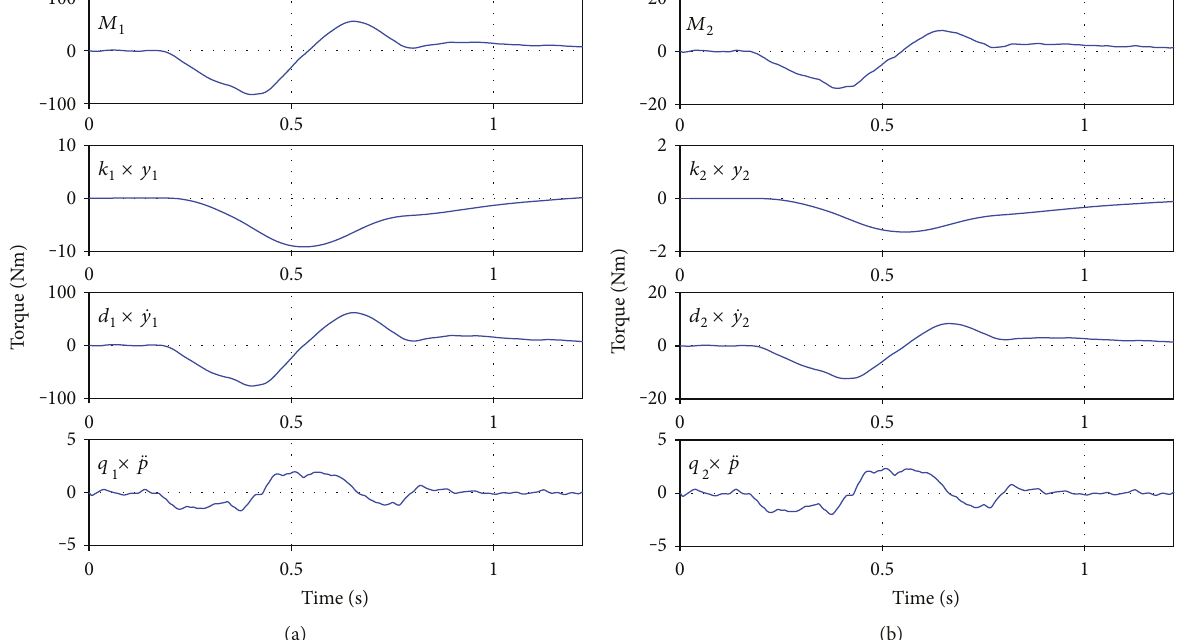
(undelayed M ) full and split into components. (b) M 1 A